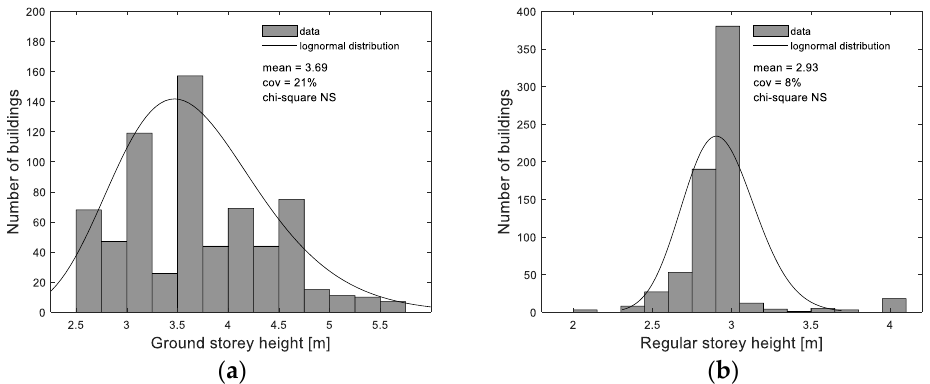
Figure 14. Distribution of ground storey ( a ) and regular storey ( b ) heights for all RC buildings.